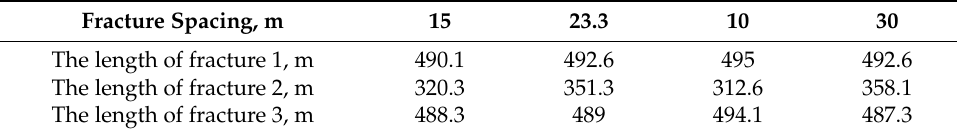
Figure 5. Effects of the different values of fracture spacing on the fracture geometry: ( a ) 10 m; ( b ) 15 m; ( c ) 23.3 m; and ( d ) 30 m. Table 2. The results of fracture length affected by different cluster spacings.